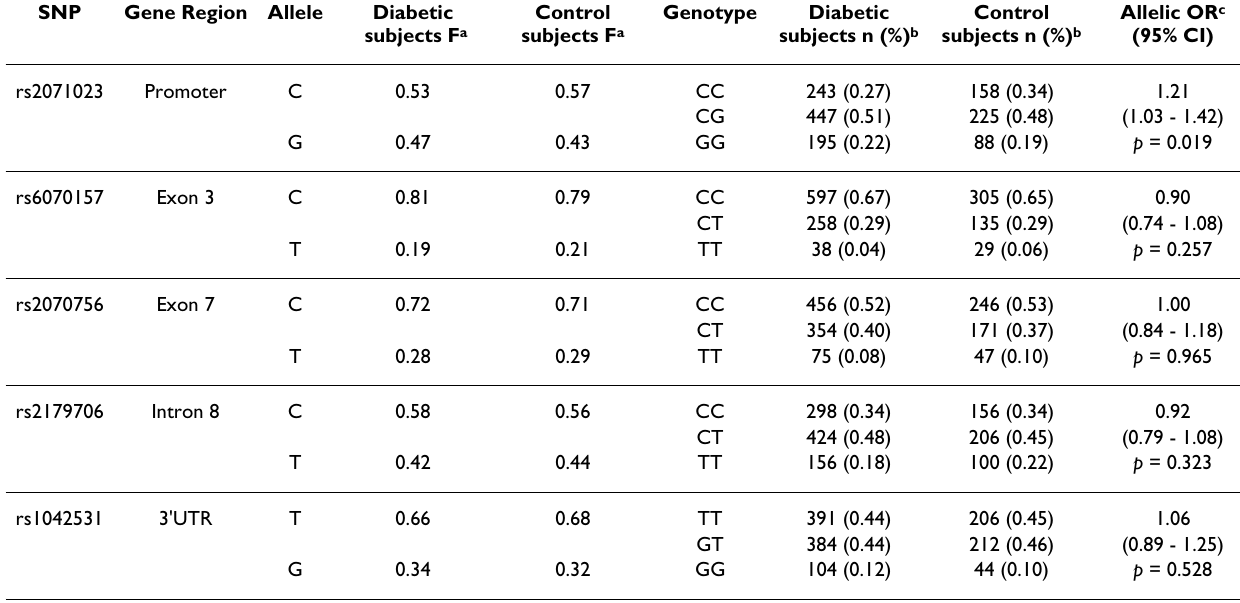
a F = Allele frequency. b Genotype frequency expressed as number of individuals, n - values in parentheses indicate percentage. c OR = odds ratio, 95% CI = 95% confidence interval. Allelic OR refers to the risk associated with a single copy of the risk allele. All values were calculated using the full dataset, the minimum age of control subjects being 35 years.